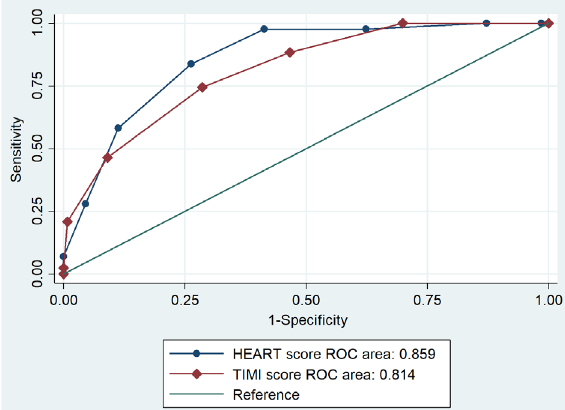
Figure 2. Area under ROC curve of HEART vs TIMI score in MACE prediction.